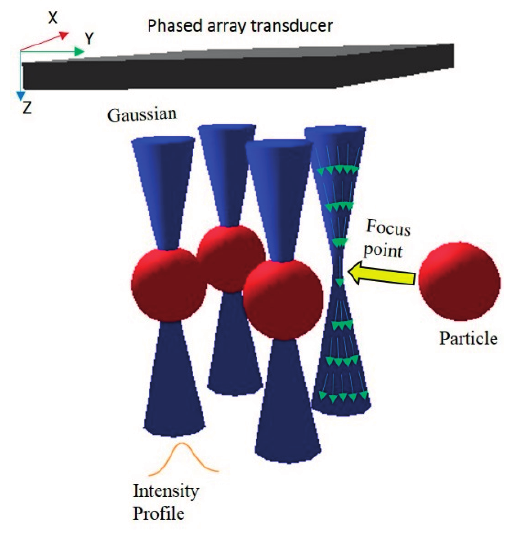
Figure 1. Schematic of the multiple trapping acoustic tweezers. The blue hyperbolic space shows the Gaussian beams generated by a phased array transducer (gray plane). The orange line is the intensity profile of Gaussian beam. The red ball is the objective particle to be trapped by the focal points in the center of beams. Green arrows denote wave propagation direction in Gaussian